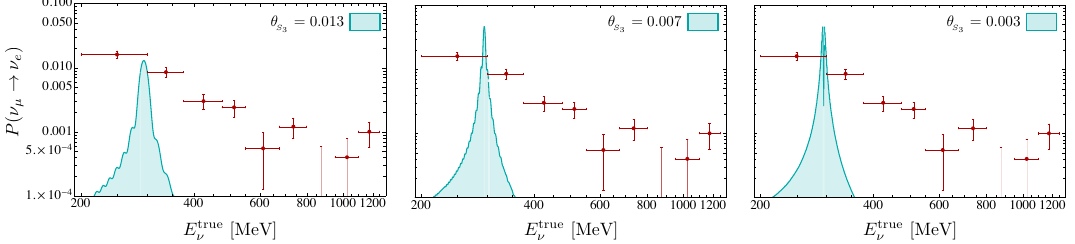
Figure 4 . The ν µ → ν e appearance probability at MiniBooNE, as a function of true neutrino energy, predicted by the toy model (2.28) assuming E res the active-sterile vacuum mixing angle θ above (right panel) the appearance probability saturation condition; see (2.31) and (2.32). The red data points with error bars were taken from figure 21 of [22]; they assume E true is a very coarse approximation. As such, they should be interpreted as a qualitative measure of MiniBooNE’s anomalous appearance probabilities.